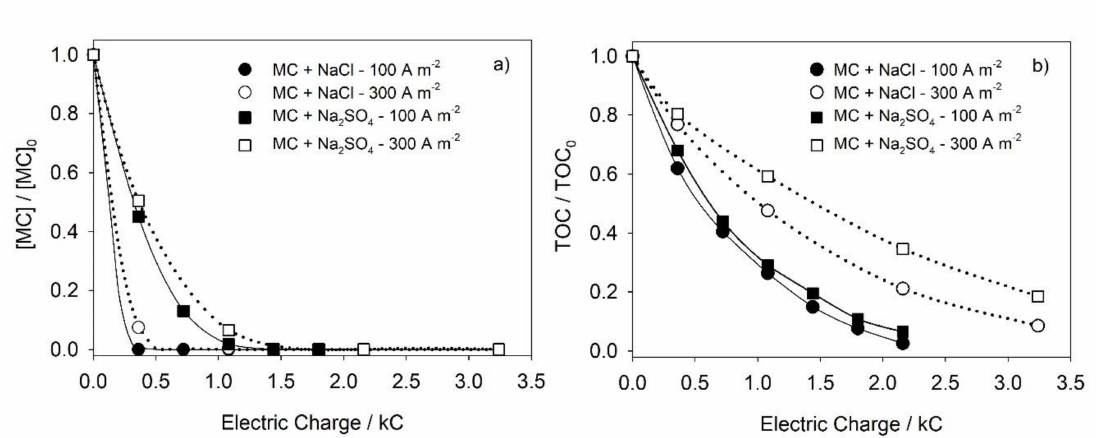
Figure 1. Variation with applied charge of the normalized ( a ) methiocarb (MC) concentration and ( b ) total organic carbon (TOC) for the electrochemical oxidation (EO) experiments performed at 100 and 300 A m − 2 using Na 2 SO 4 or NaCl as the supporting